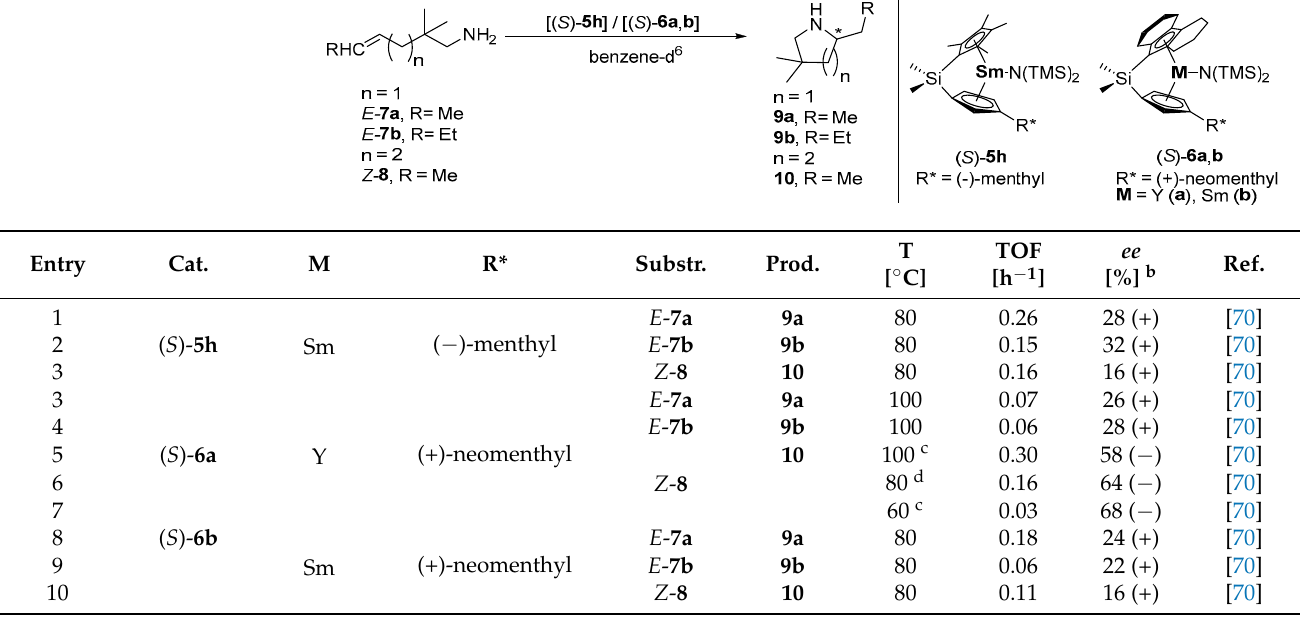
Table 3. Catalytic asymmetric hydroamination of 11 and 12a , b using chiral rare earth metal